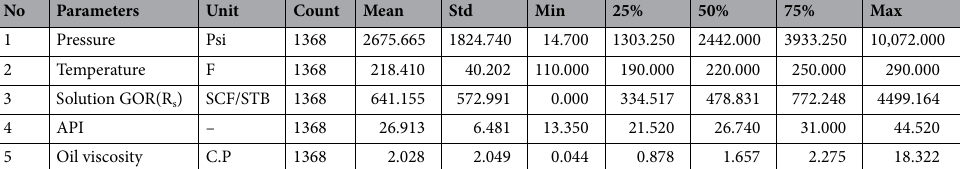
Table 1. Statistical ranges and parameters related to inputs/outputs employed for developing